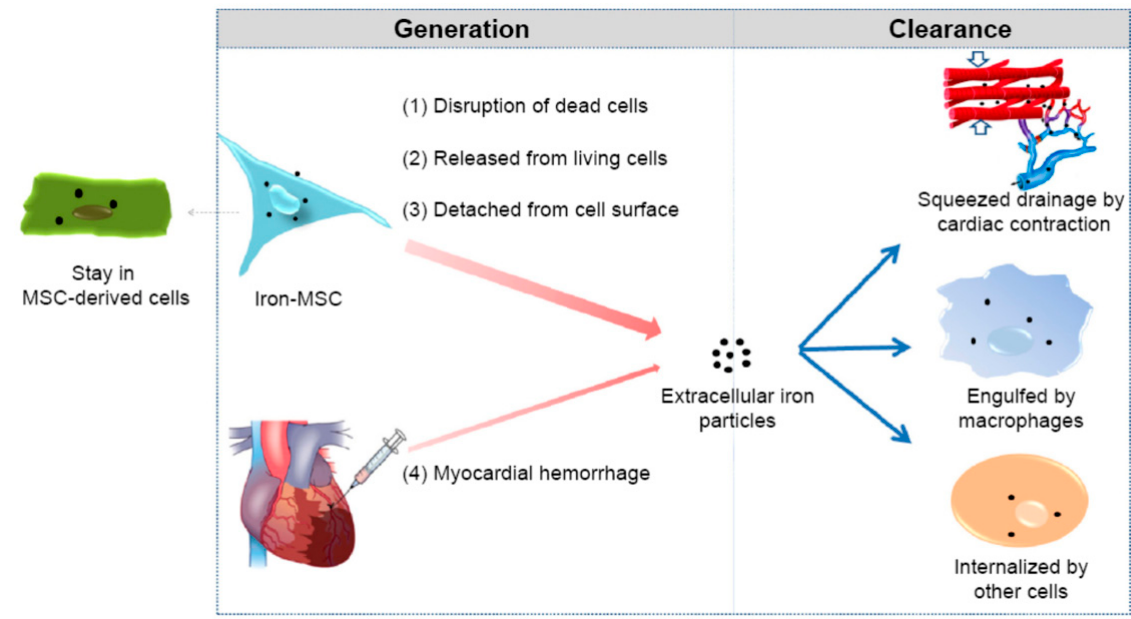
Figure 3. Generation and clearance of the extracellular SPIONs in the myocardium. Reprinted from Huang et al. [90] following the Creative Commons Attribution (CC BY) license (http://creativecommons.org/licenses/by/4.0/) (accessed